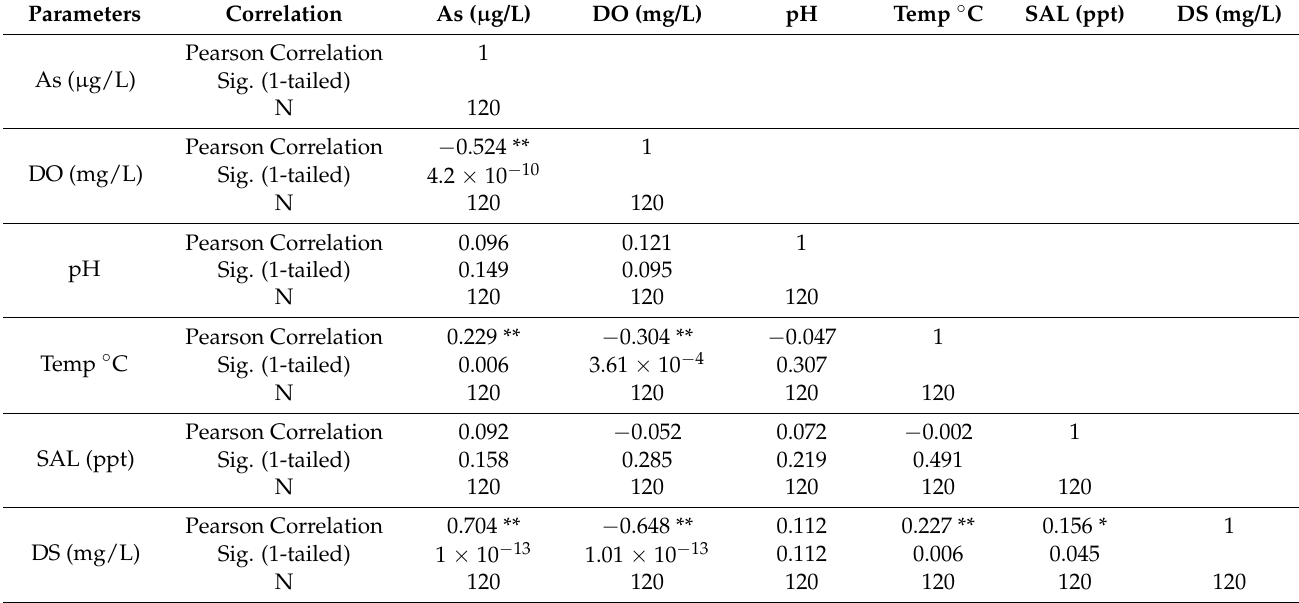
Table 4. Correlation analysis between As ( μ g/L) and physico-chemical parameters in the Langat River.